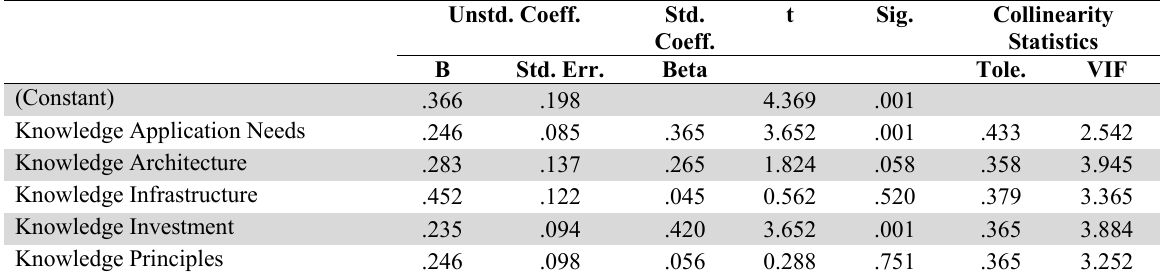
Unstd. Coeff. Std. Coeff.